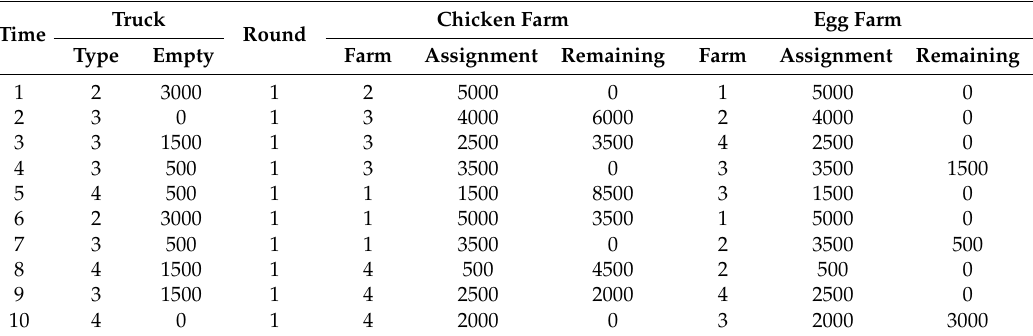
Table 8. Results of the decoding